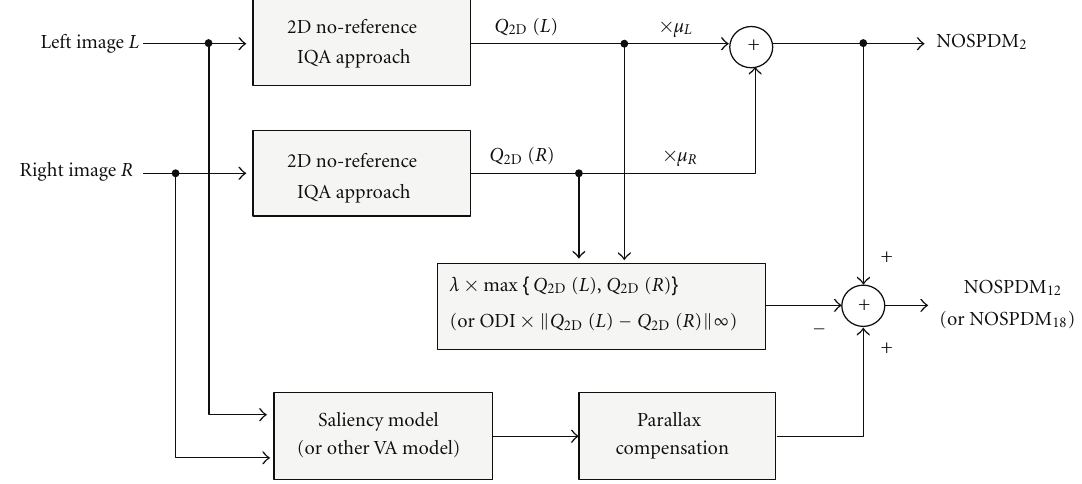
Figure 8: Five steps of NOSPDM